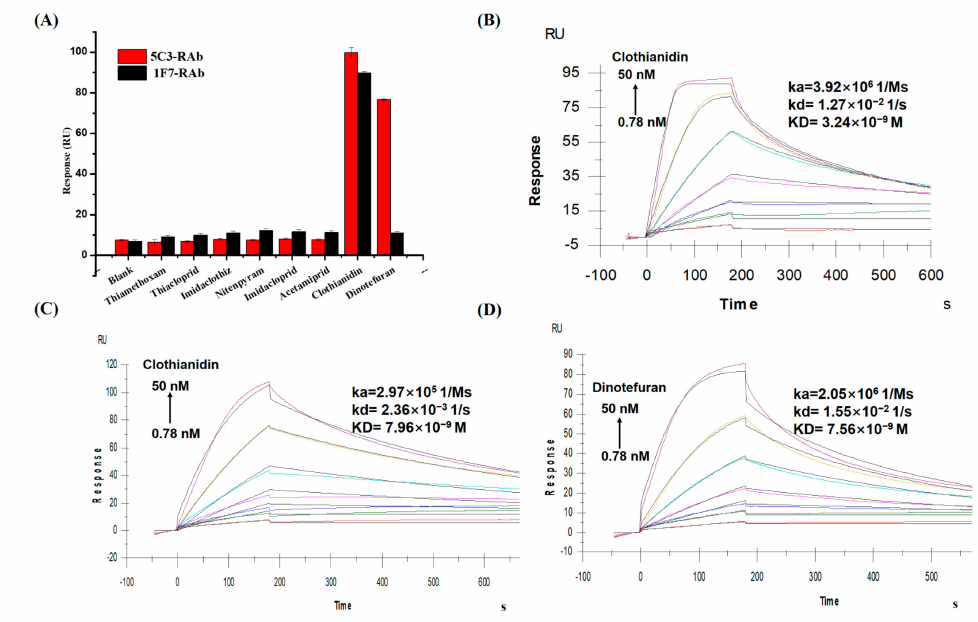
Figure 3. Full -length RAbs with analytes measured by non-competitive SPR. Binding selectivity of antibodies towards 8 neonicotinoids at the same concentration of 50 nM ( A ). Kinetic affinity tests of 1F7-RAb with clothianidin ( B ); 5C3-RAb with clothianidin ( C ); 5C3-RAb with dinotefuran ( D ). ka: association rate; kd: dissociation rate; KD: dissociation equilibrium